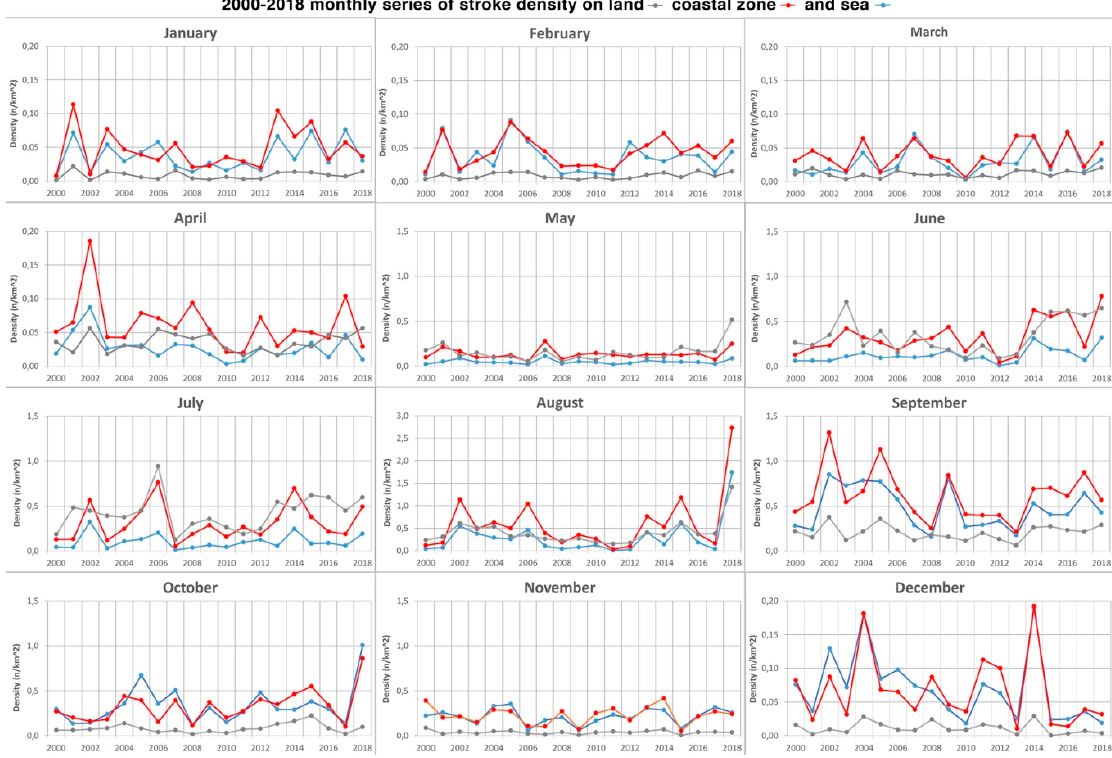
Figure 9. Monthly mean stroke density on sea, land, and coastal areas for the studied period.